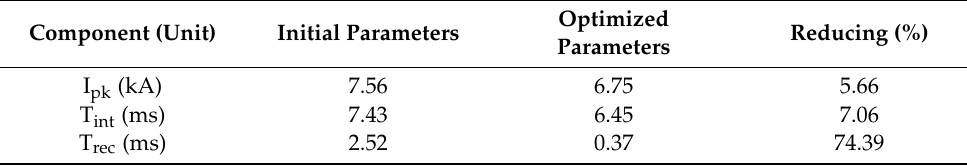
Table 5. Results of the optimal parameters for the